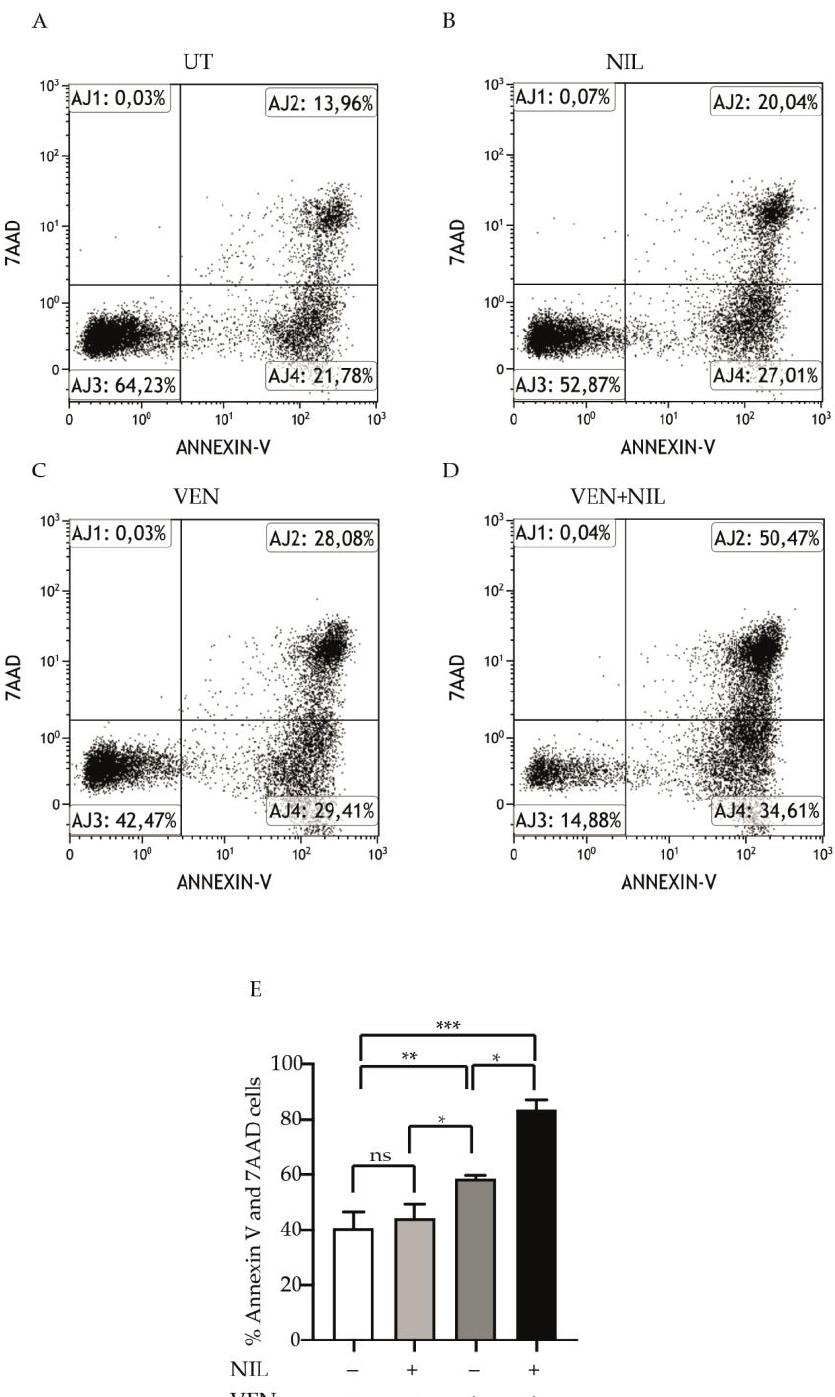
Figure 2. Pro-apoptotic effect of BCL2 and BCR-ABL1 dual targeting in committed CML CD34-positve cells. ( A – D ) Representative experiment of bone marrow CD34-progenitors untreated ( A ) or treated with Nilotinib (2 μ M) (B), Venetoclax (400 nM) ( C ) or their combination ( D ). After 24 h cells were collected and stained with Annexin V/7-AAD. Scatter plots indicate the unstained (AJ3) and Annexin V (AJ4), Annexin V/7-AAD (AJ2) or 7-AAD (AJ1) stained cells. ( E ) Histograms report the average percentage of Annexin and 7-AAD cells obtained from CML patients ( n = 3). Bars indicate the standard deviation resulting from average of three patients. Statistical significance was calculated by analysis of variance (ANOVA) plus Bonferroni’s posttests ( p < 0.05 *, p < 0.01 **, p < 0.001 ***). UT: Untreated, NIL: Nilotinib, Ven: